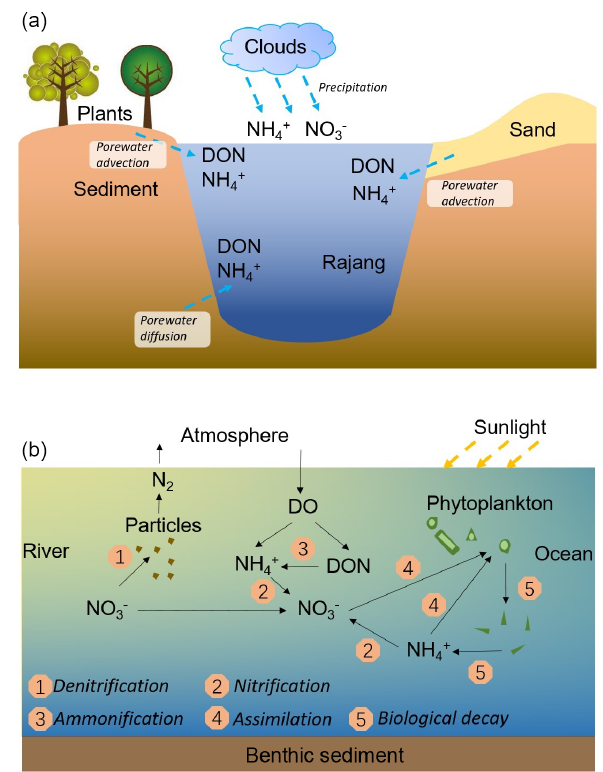
Figure 8. Sketch of the N input pathways in the Rajang estuary (a) and N reactions during the mixing between the river water and the coastal ocean water obtained in the current research (b)